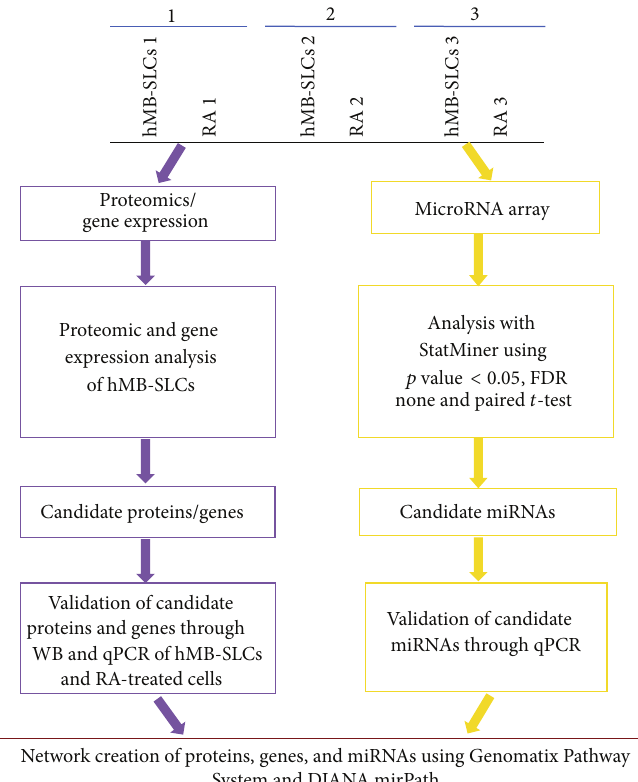
Figure 1: Experimental design and analysis of hMB-SLCs. Three biological cell replicates obtained by untreated and RA-treated cells were compared for proteome, genes, and microRNAs expression